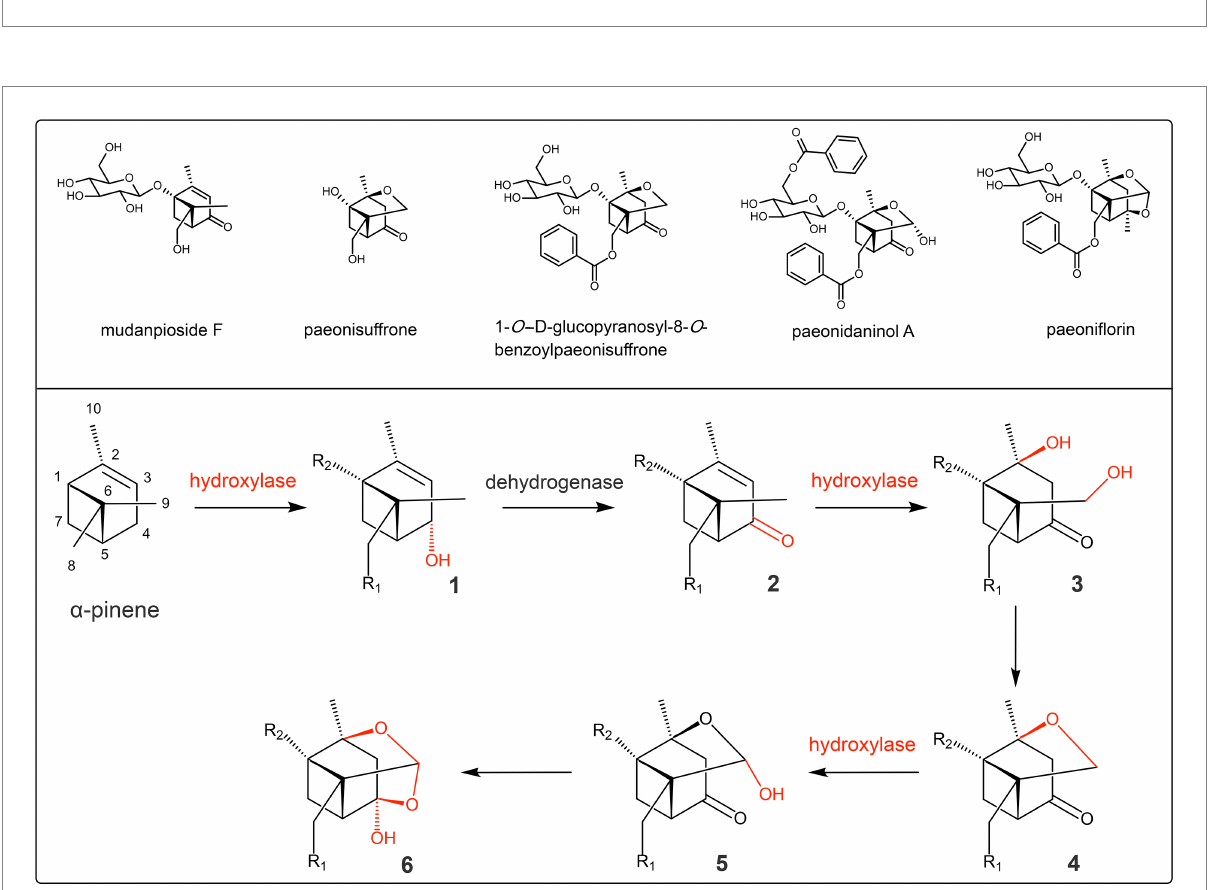
FIGURE 3 Predicted biosynthesis pathway of the hemiketal–acetal linkage of paeoniflorin. Compounds 1 and 3 are possible intermediates; the representative of compound 2 is mudanpioside F; the representatives of compound 4 are paeonisuffrone and 1- O -D-glucopyranosyl-8- O - benzoylpaeonisuffrone; the representative of compound 5 is paeonidaninol A; the representative of compound 6 is paeoniflorin; R 1 and R 2 represent the possible modification